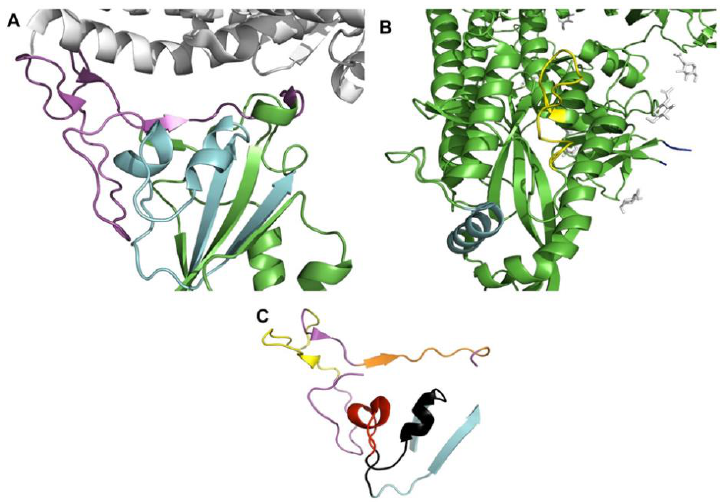
Figure 1. ( A ) Shows the structural configuration of the spike glycoprotein (green) binding with re- ceptor ACE2 (white) (PDB: 7DF4). The receptor-binding domain of the spike glycoprotein shows two distinctive regions essential for binding; RBDg (cyan) and RBDp (magenta). ( B ) Shows the cleavage sites of TMPRSS2 (yellow), furin (blue) in addition to N-acetylglucosamine (NAG) moieties (white). ( C ) shows the selected epitopes within RBDg (peptides A, D) and RBDp (peptides B, C) colored differently including: peptide A (red), peptide B (yellow), peptide C (black), peptide D (or- ange). D